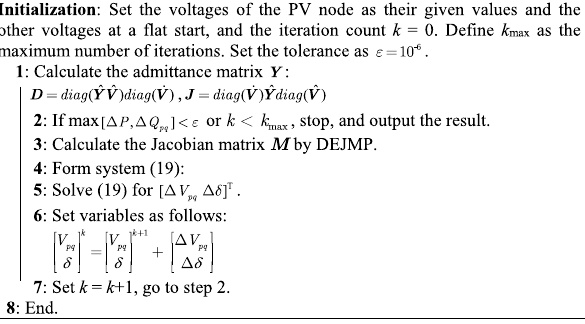
Algorithm 2. DEJMP-based PF.